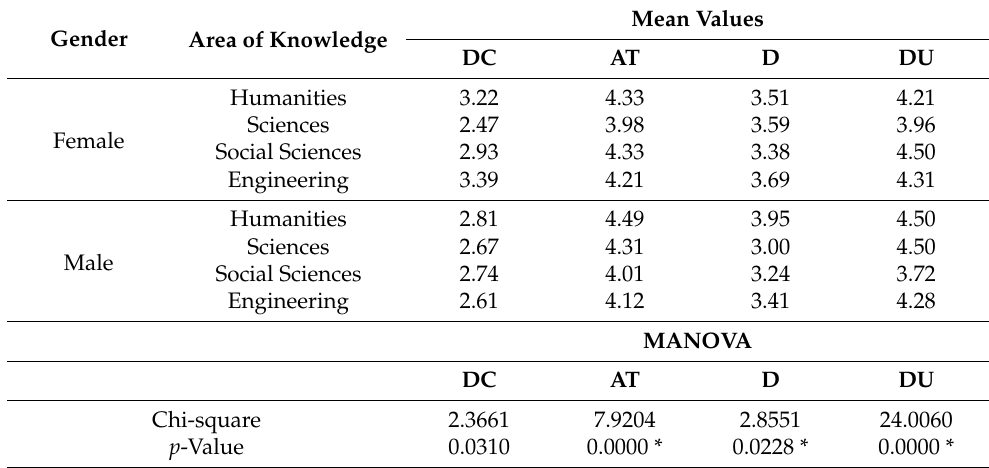
Table 10. Mean answers (out of 5) and MANOVA test statistics when participants are differentiated by area of knowledge and gender.